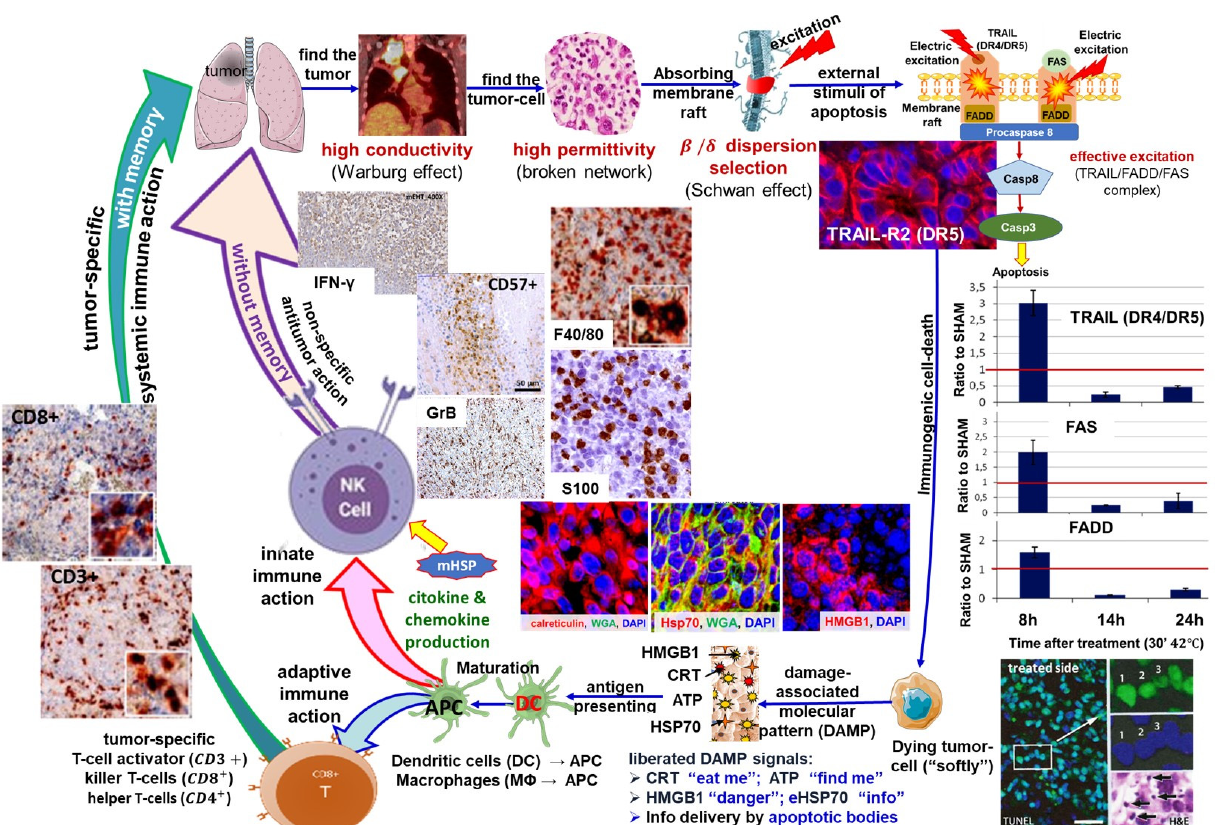
Figure 13. The negative feedback structure of the abscopal effect shows a complex loop from recognizing the antigens to their use in tumor-specific immune processes. The experiments are from various publications. The loop summary only demonstrates how the loop works. The measurements are from the following publications: the selection line reviewed [101], TRAIL-R2-FAS-FADD complex [153];